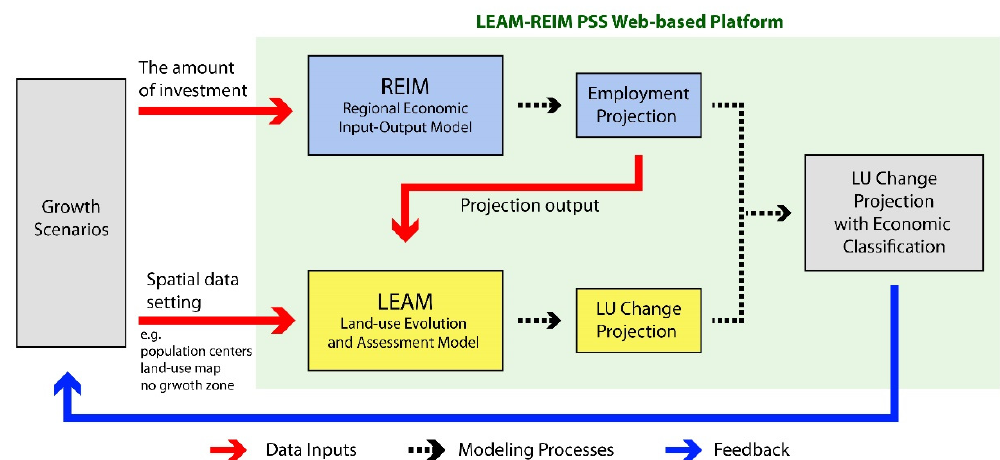
Figure 1. The framework of Land-use Evolution and Assessment Model (LEAM)-Regional Economic Input-Output Model (REIM) planning support system (PSS) architecture. LEAM and REIM are tightly coupled allowing users to easily test alternative scenarios. Once users establish scenario(s) to test and feed input data to the PSS tool, the system produces detailed land-use estimations without ‘human intervention’ answering both “what-if” and “so-what” questions within the context of the policy-making process.